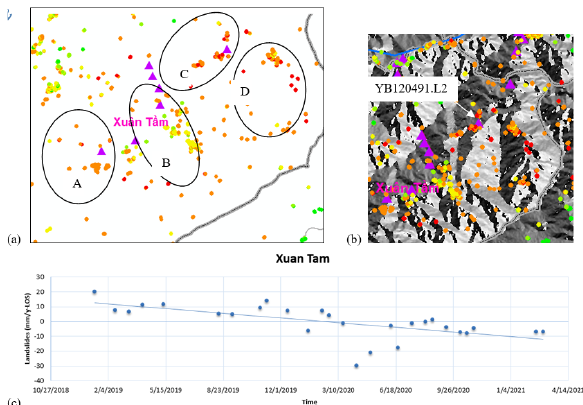
Figure 8. (a) Distribution of permanent scatter points showing landslide rate, (b) the positions of PS points matched with survey point in Xuan Tam commune are superimposed on aspect map, (c) the chart of landslide point selected from (b) 5.4 Phong Du Thuong commune landslide Phong Du Thuong is located in the southwest of Van Yen, this area has an average altitude of 200 m to 1500 m. The distribution of PS points here is quite concentrated in an area along the inter-commune road and the streams. The location with many PS points has been highlighted by the